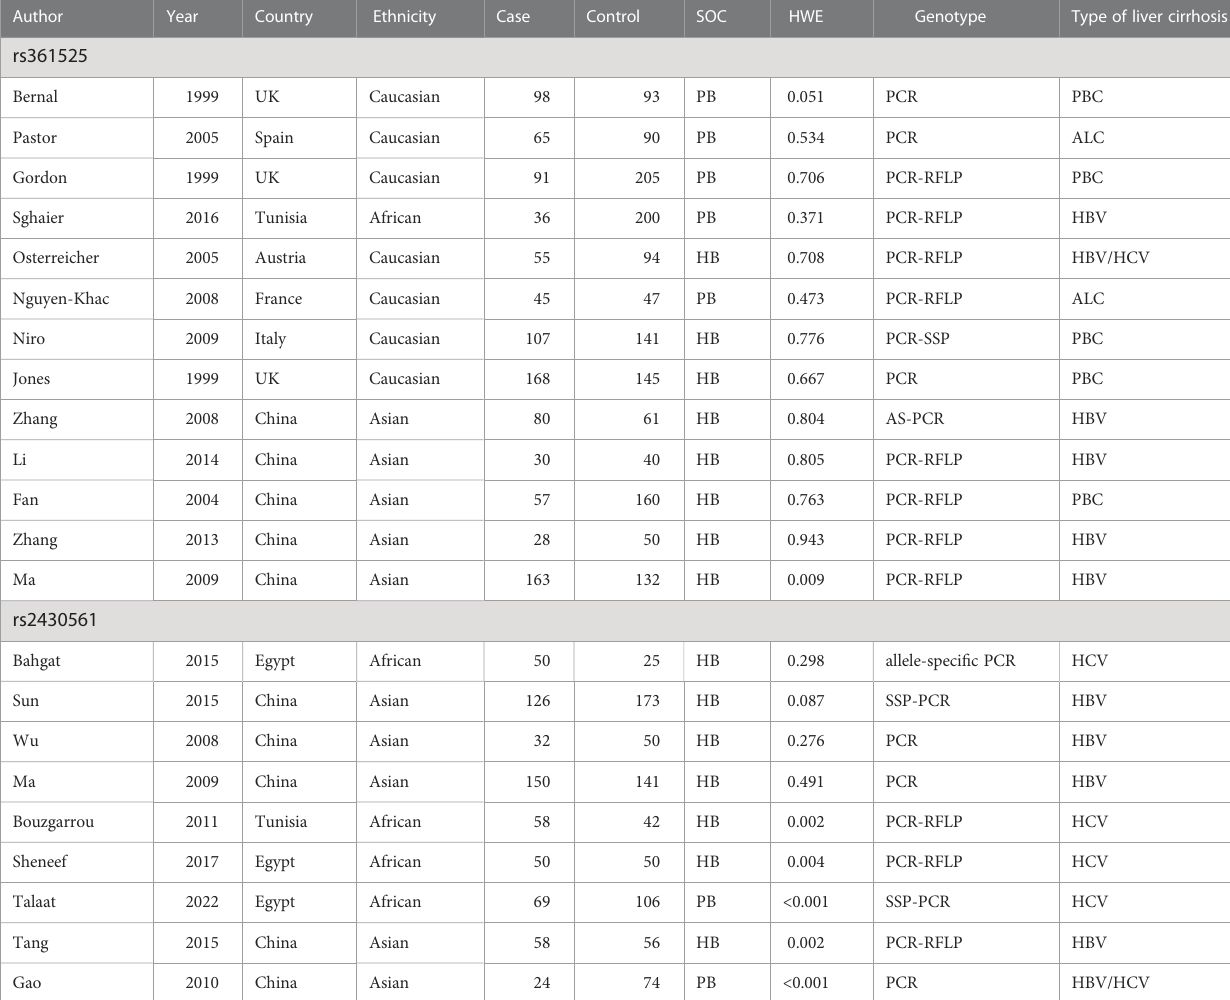
TABLE 1 Characteristics of included studies about polymorphisms in TNF- a and IFN- g genes and cirrhosis of liver risk.